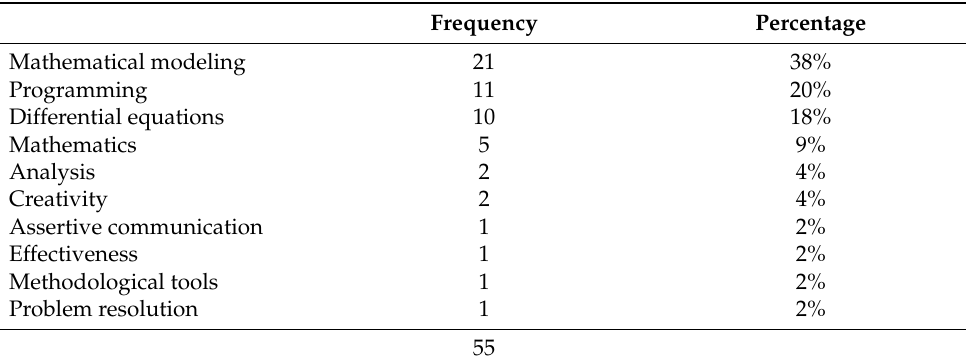
Table 4. Skills students used during the MMC.